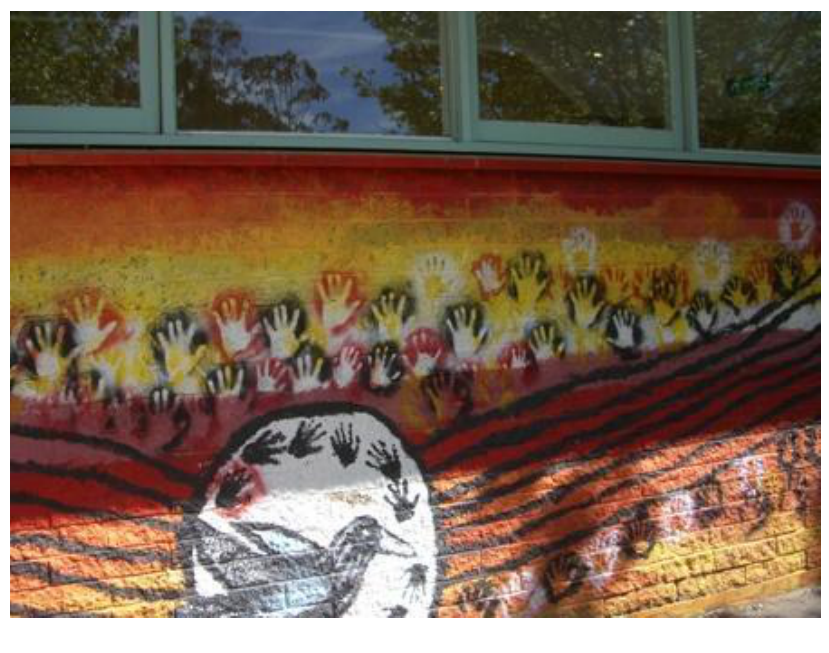
Figure 21. Hands mural at Mt Majura Primary School, Australian Capital Territory.